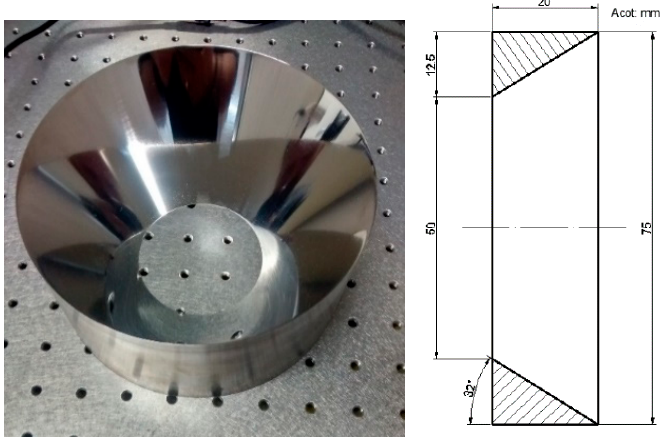
Figure 5. The conic mirror manufactured in stainless steel.